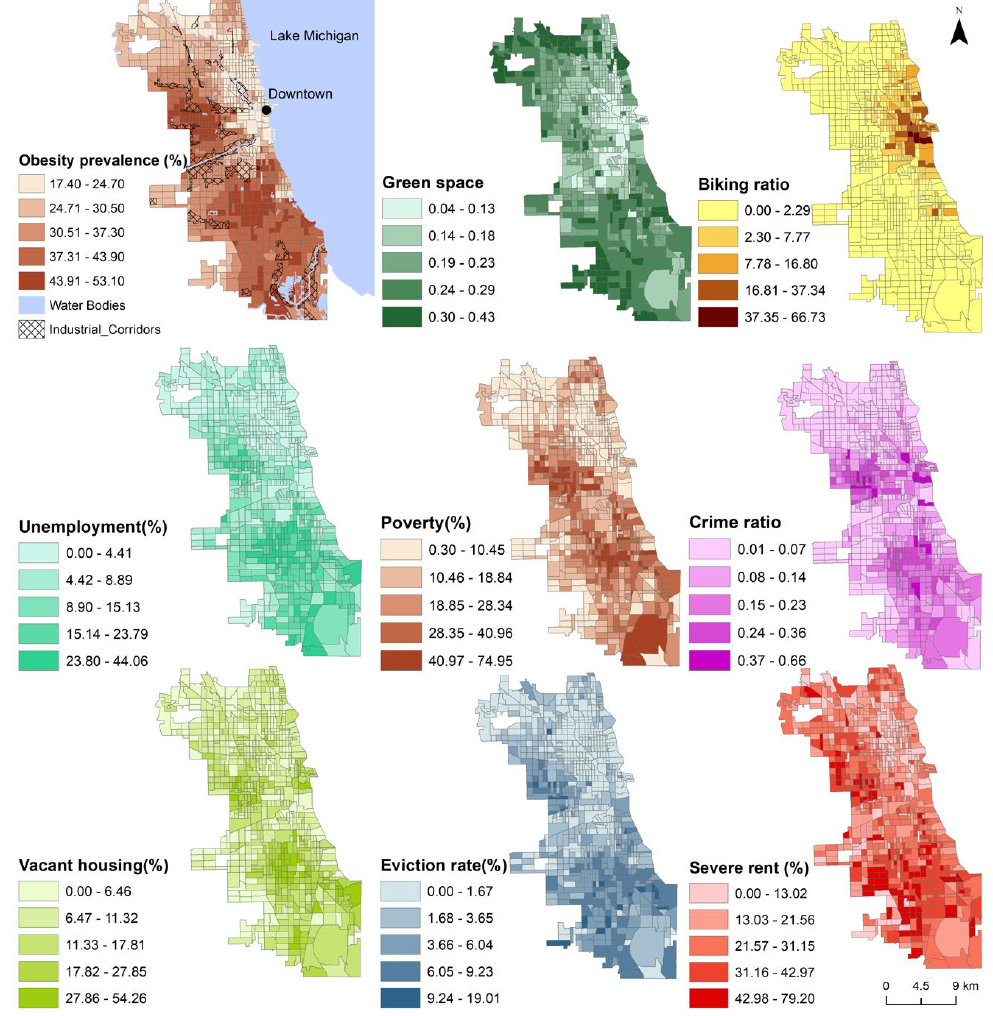
Figure 1. Tract-level obesity prevalence (%) and the socio-environmental determinants. Aspatial Random Forest and GRF Results